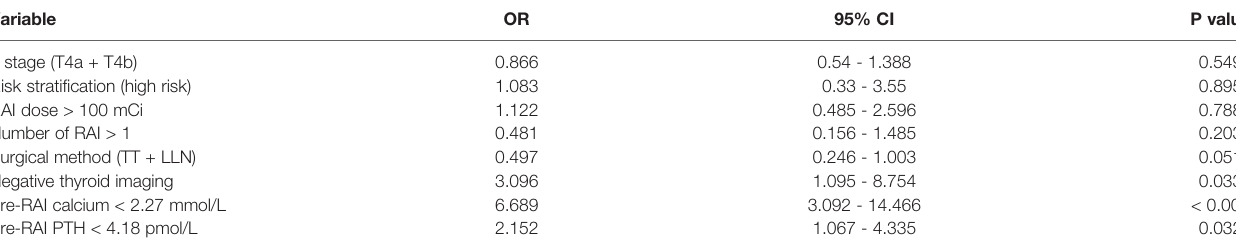
TT, total thyroidectomy; LLN, lateral lymph node dissection.